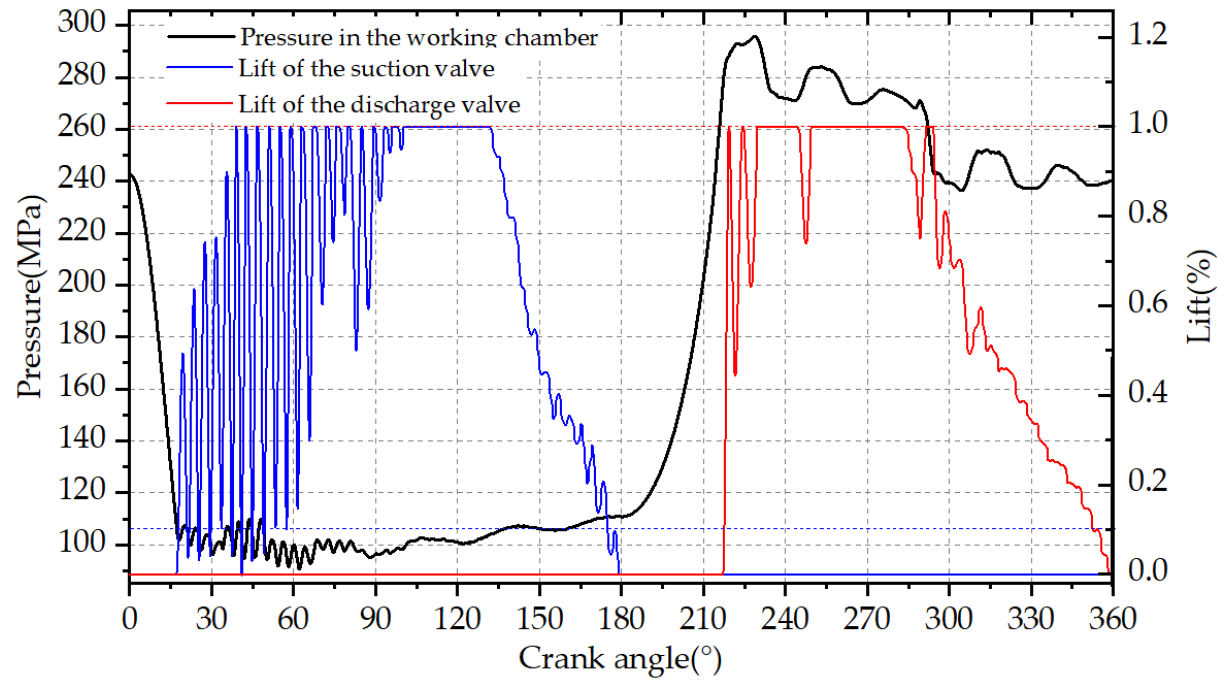
Figure 12. Lifts of the poppet valves.